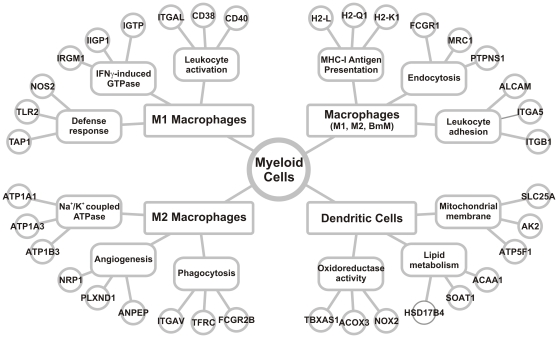
Plasma membrane protein signatures of myeloid cells identify unique cell functions.Gene ontology analysis of plasma membrane proteins enriched in M1 macrophages, M2 macrophages, all macrophage types (BmM, M1, and M2), and BmDCs identifies functional categories of proteins enriched in each cell type (p<0.05 with Benjamini-Hochberg correction). The top three functional annotations are presented for each cell type along with three representative proteins.